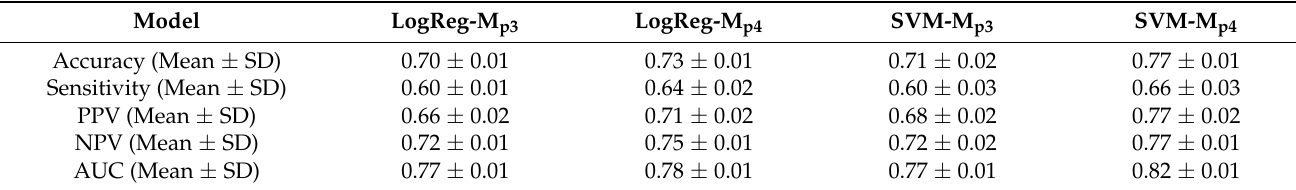
Table 2. Model performances using repeated